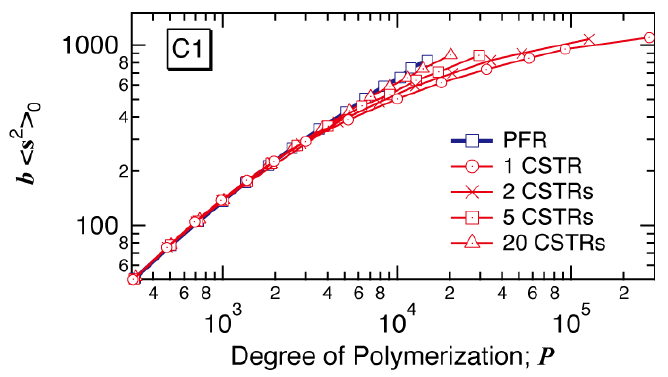
Figure 5. Effect of the number of CSTRs in the tanks-in-series model on the relationship between the mean-square radius of gyration <s 2 > 0 and degree of polymerization P . The MC simulation data were taken from [18].